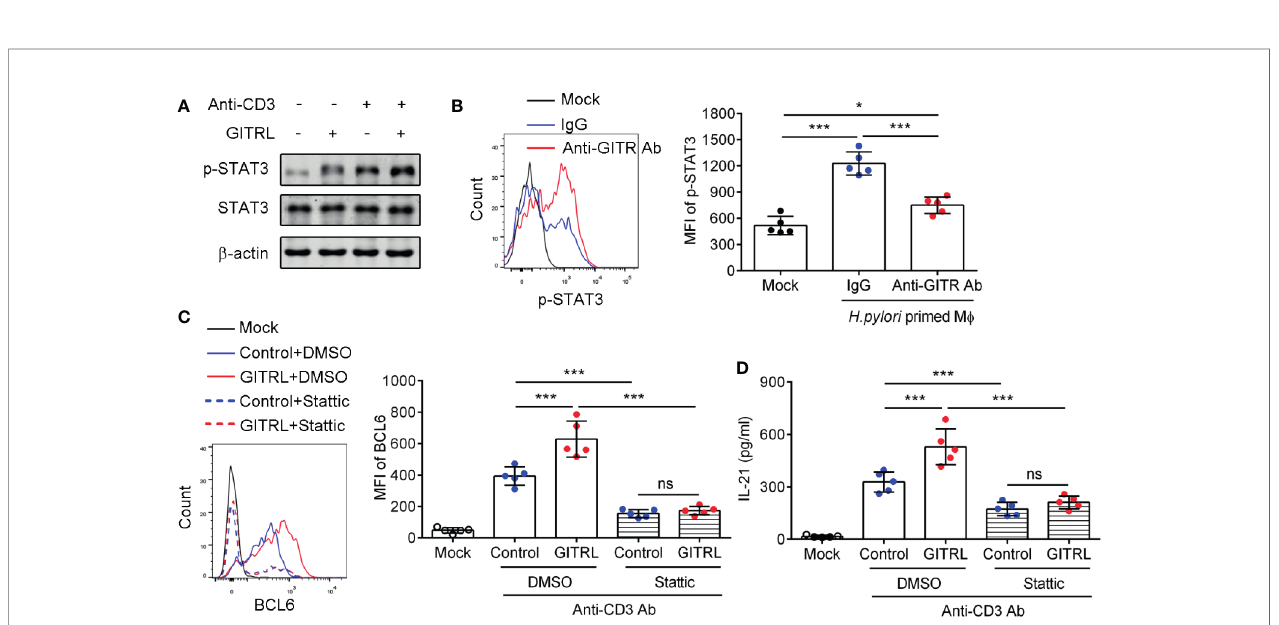
FIGURE 4 | Glucocorticoid-induced tumor necrosis factor receptor (GITR) promoted IL21 + TFH-like cell polarization dependent on the STAT3 signal pathway in Helicobacter pylori infection. (A) Gastric CD4 + T cells were isolated from the gastric mucosa of H. pylori -positive patients and treated with CD3 agonist Ab or recombinant GITRL protein for 12 h. Western blot was performed to detect the expression of phosphorylated STAT3 (Ser727) and total STAT3. (B) Monocyte- derived macrophages were infected with H. pylori (multiplicity of infection = 20) and co-cultured with gastric CD4 + T cells with the addition of control IgG or anti-GITR- neutralizing Ab. At 12 h later, the phosphorylated level of STAT3 (Ser727) in CD4 + T cells was determined by fl ow cytometry. (C, D) Sorted gastric CD4 + T cells were pretreated with stattic or dimethyl sulfoxide for 1 h and stimulated with CD3 agonist Ab or recombinant GITRL protein for 3 days. (C) The BCL6 expression in CD4 + T cells was detected by fl ow cytometry. (D) The IL-21 concentration in the culture supernatant was determined by ELISA. One-way ANOVA was used to compare among three or multiple groups. Data represent mean ± SD from at least three independent experiments. ns, P > 0.05; * P < 0.05; *** P < 0.001.